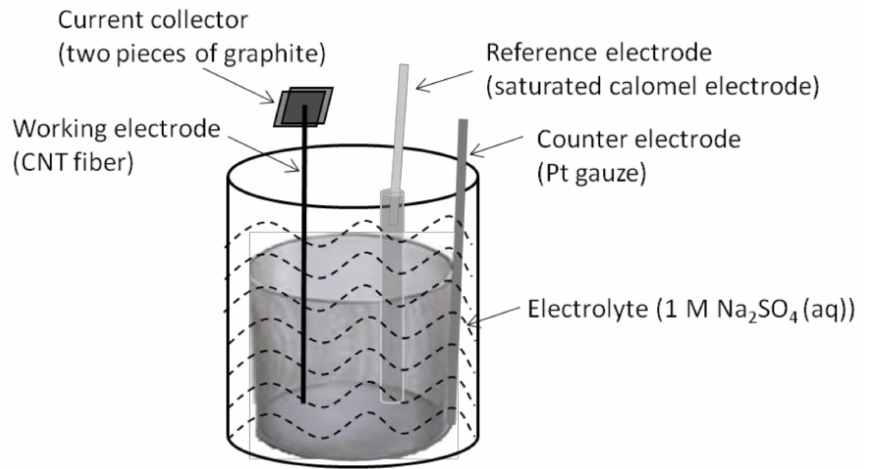
Figure 7. Schematic representation of the three-electrode cell used to test the electrochemical perfor- mance of individual CNT–MnO 2